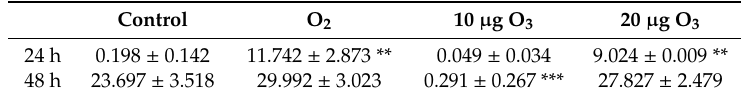
Table 1. Mean ± SE of percentage values of cytoplasmic area occupied by the small lipid droplets budding from the main central droplet. Asterisks indicate significant di ff erence from control (** p < 0.01; *** p < 0.001).